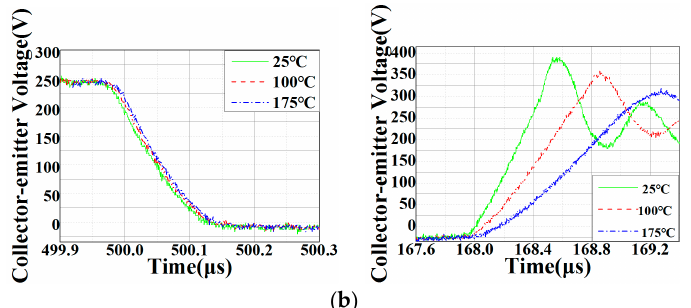
Figure 4. Switching time of power devices at different temperatures. ( a ) Si IGBT; ( b ) SiC MOSFET. Table 1. Test parameters measured by the DPT.